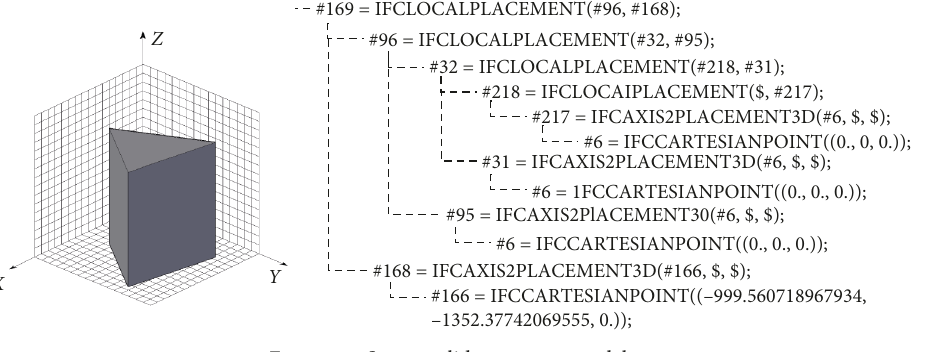
Figure 5: Swept solid geometry model.